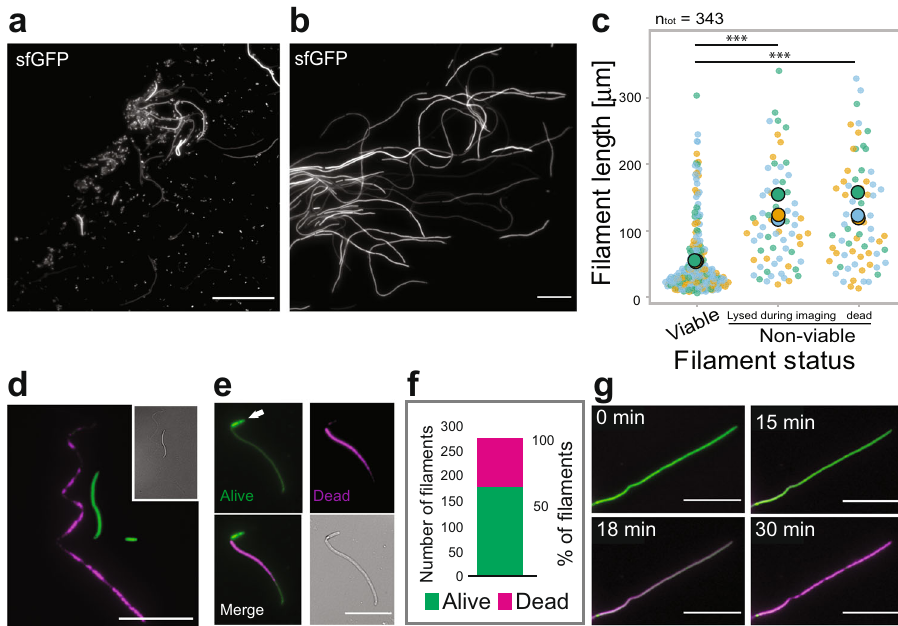
Fig. 1 Shorter fi laments are more likely to be viable and revert to rod cells. a Fluorescence microscopy image showing a mixture of sfGFP-expressing short cells and fi laments released from bladder cells after urine exposure. b Length heterogeneity in a cluster of fi laments. c Shorter fi laments are more likely to be viable after a round of infection. A total of 343 fi laments were analysed from time-lapse imaging of three different infection experiments (Blue, Green and Yellow dots, respectively). Large, coloured dots represent the average of the respective experiment. Only cells classi fi ed as “ fi laments ” (i.e., equal to or longer than 8 μ m) were included in this analysis. Overall average fi lament lengths were 56.3 ± 56.5 ( n = 208) for viable, 122.6 ± 79 ( n = 68) for dead, and 117.6 ± 73,4 ( n = 67) for dying (mean ± SD). P values are from unpaired two-tailed t tests. *** P < 0.0001. 95% con fi dence interval. d WT UTI89 fi laments were differentially stained to assess viability (LIVE/DEAD, green and magenta, respectively). e Filaments that divided at least once during the fi rst 120 min were classi fi ed as viable (white arrow). f A total of 275 fi laments from three infection experiments were analysed with LIVE/DEAD staining. g A representative dying fi lament, transitioning from green to magenta over time (see Supplementary Movie SM5). Scale bars a = 40 μ m, Rest = 20 μ m. Source data are provided as a Source data fi